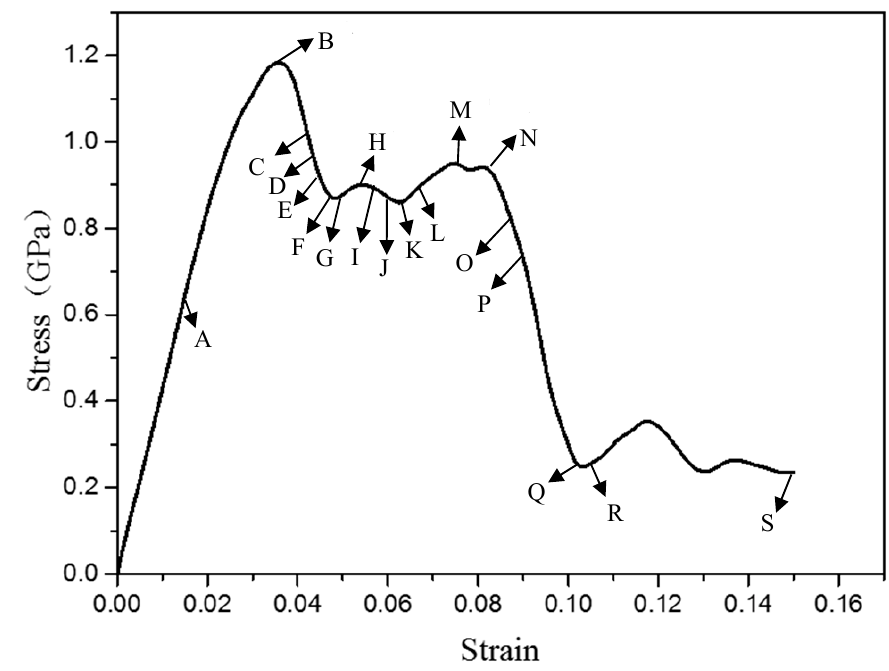
Figure 2. Strain–stress behavior during compression process.